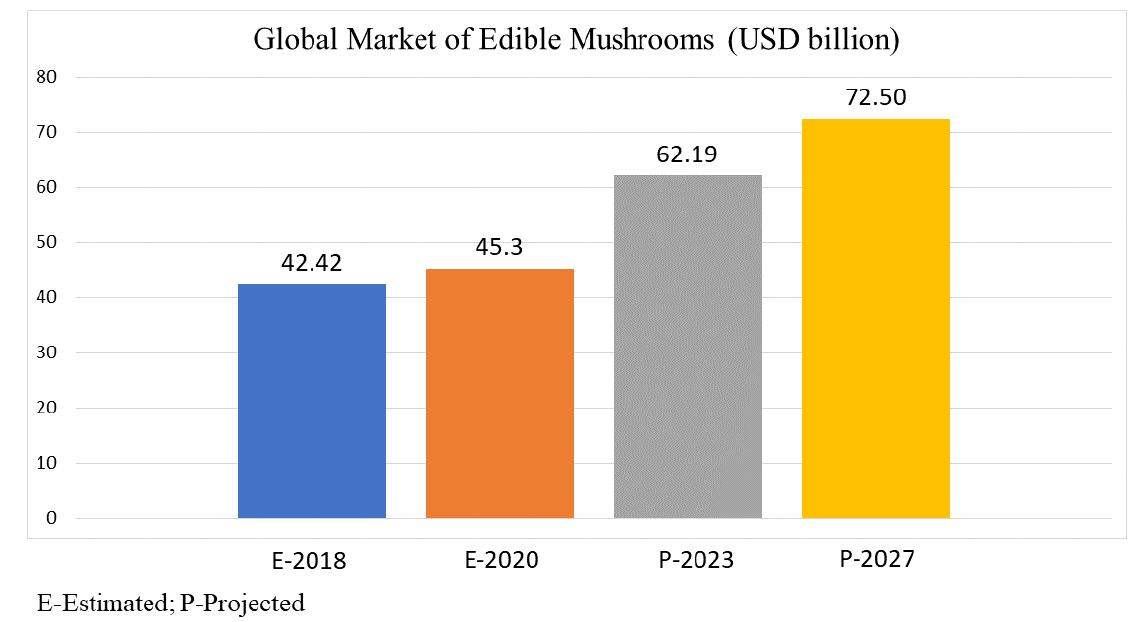
Figure 4. Global annual market revenue (USD billion) of edible mushrooms estimated and projected by Research and Markets [13].